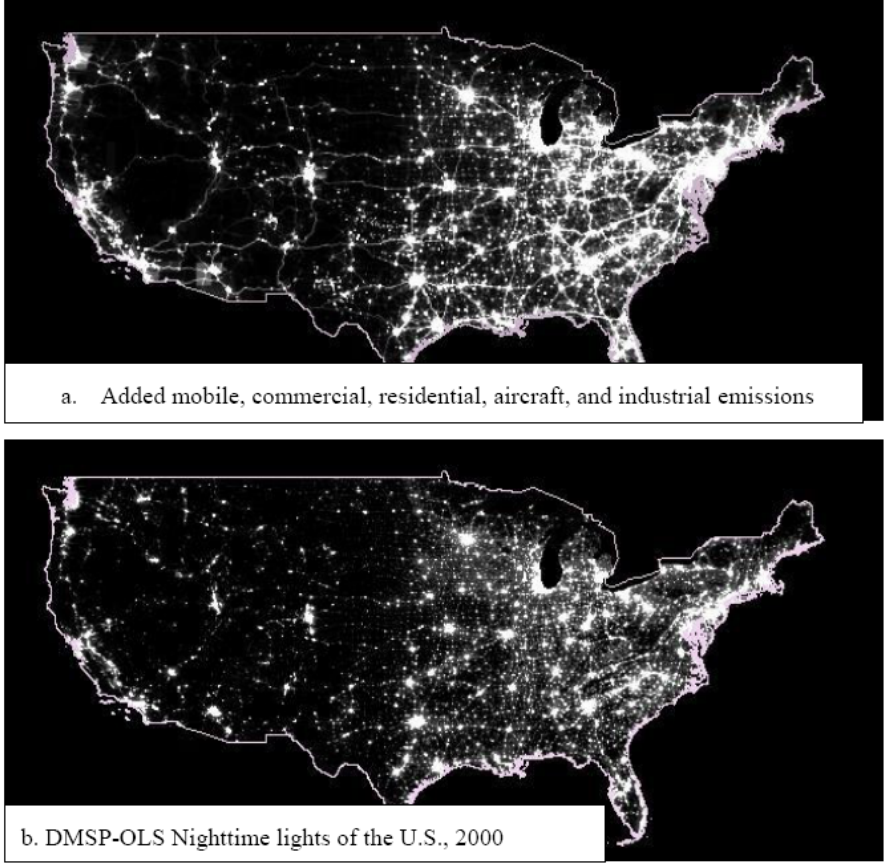
Figure 5. ( a ) Vulcan mobile, commercial, residential, aircraft, and industrial sectors added together; ( b ) DMSP-OLS Nighttime lights of the U.S.,